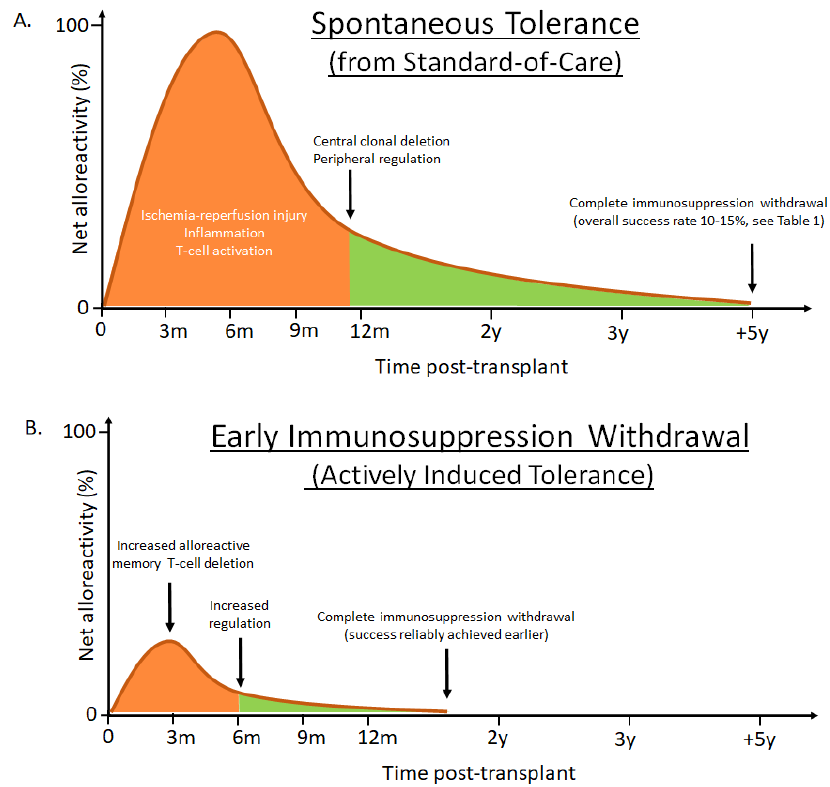
Figure 2. Conceptualized liver transplantation outcomes using either standard-of-care immunosuppression or enhanced tolerance induction strategies. ( A ) Successful immunosuppression withdrawal can, at least in part, be explained by the balance between early triggered alloreactivity (orange) and a gradually re-establishing tolerogenic liver environment (green). When immunosuppression withdrawal is